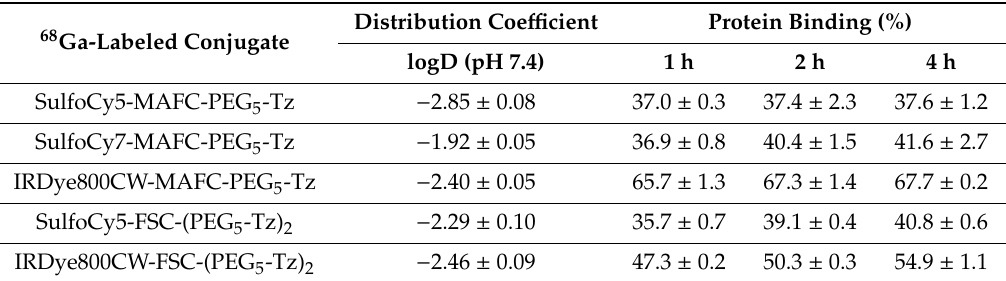
Table 1. Distribution coefficient (logD) and protein binding of 68 Ga-labeled FSC-based Tz-bearing hybrid imaging agents.